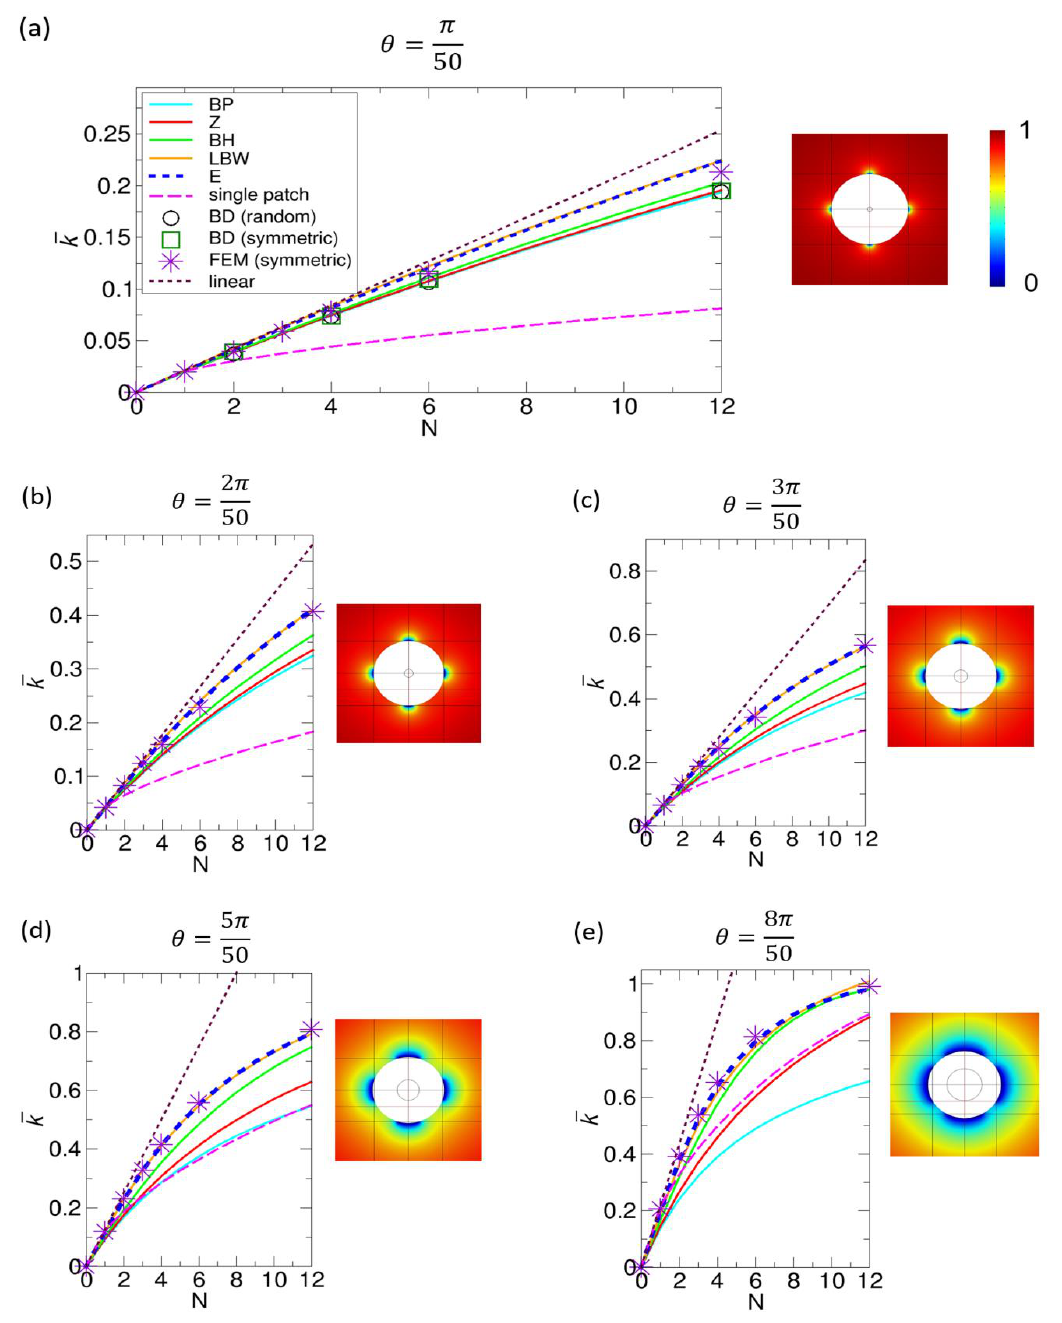
Figure 7. Comparison of the normalized rate constants k as functions of the number of patches N , obtained from various methods for various sizes of reactive patches, whose θ are ( a ) 3.6 ◦ ( π /50 ) , ( b ) 7.2 ◦ ( 2 π /50 ) , ( c ) 10.8 ◦ ( 3 π /50 ) , ( d ) 18 ◦ ( 5 π /50 ) , and ( e ) 28.8 ◦ ( 8 π /50 ) for a range of N up to 12. The reactive area fraction of a single patch for each case is 0.000987 for π /50, 0.00394 for 2 π /50, 0.00886 for 3 π /50, 0.0245 for 5 π /50, and 0.0618 for 8 π /50. The figures next to the plots show the concentration color maps for six patches. Since the maps are on two-dimensional planes, only four patches are shown.